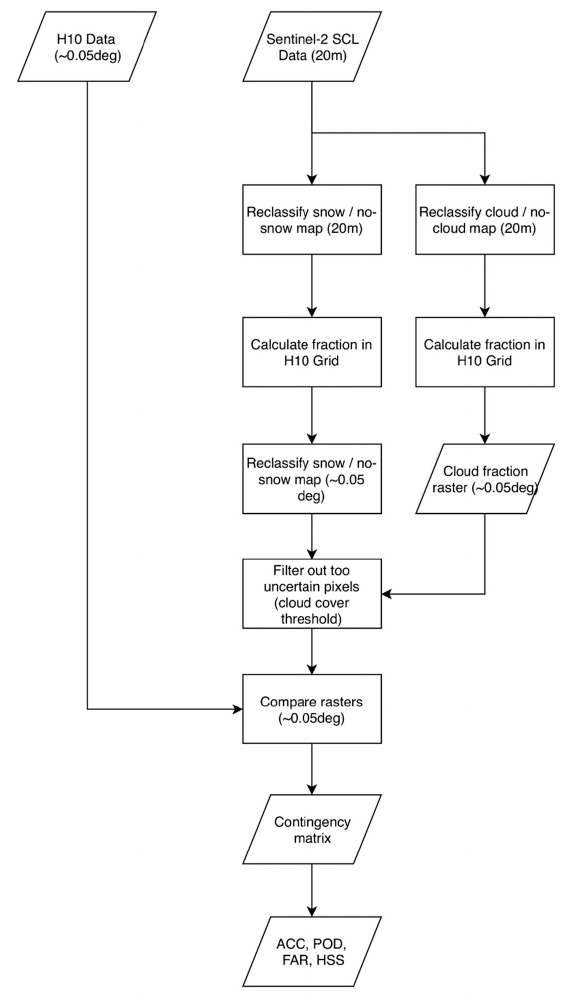
Figure 10. Flowchart of comparison procedure of H10 product.